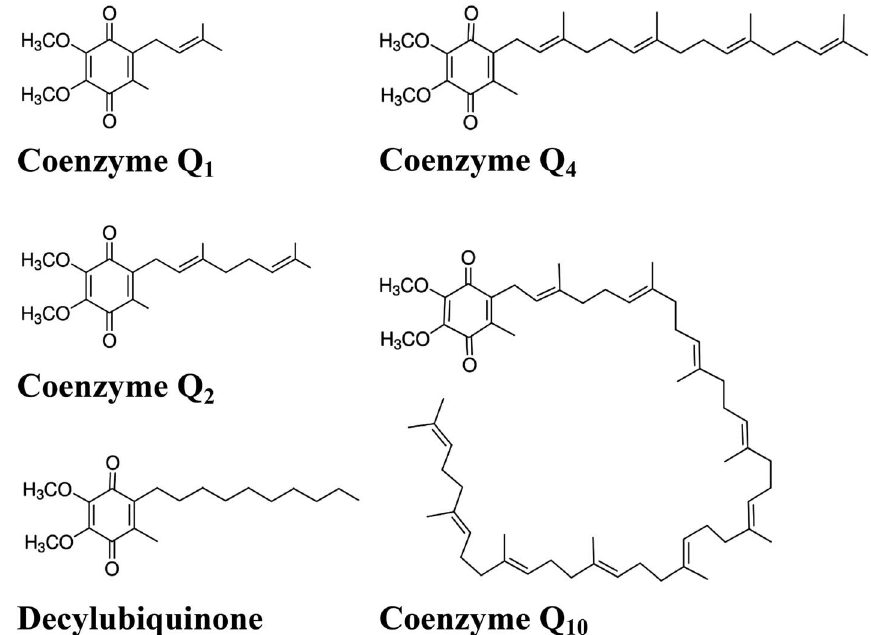
Figure 1. Chemical structures of the tested